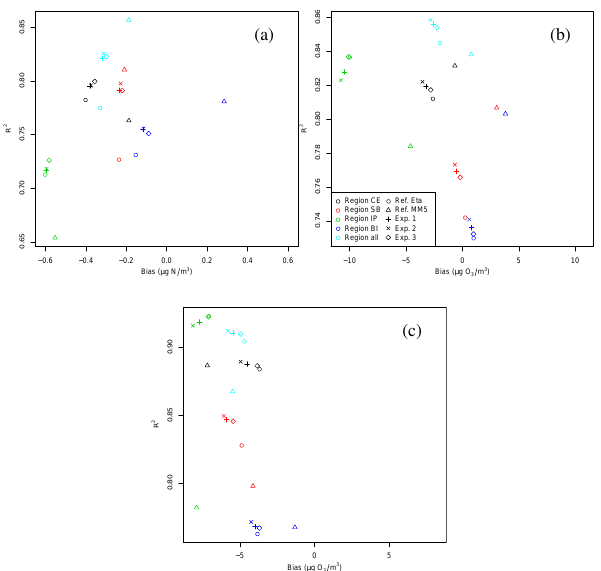
Fig. 10. Verification statistics for daily-averaged NO 2 (a) , daily-averaged O 3 (b) and daily-maximum O 3 concentrations (c) . These were based on the time series of the mean over stations, averaged over different regions (Figs. 7, 8 and 9). Results for the different simulations and regions are denoted by different point types and colours. Note that the ranges of the x- and y-axes differ between the three panels.